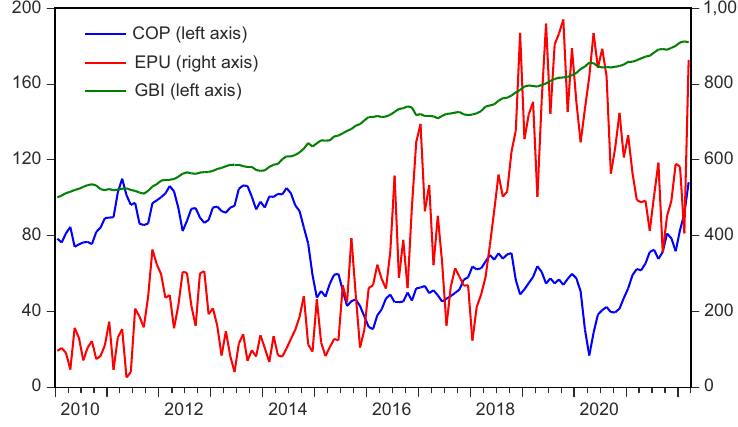
Figure 1. The trends of COP, EPU and